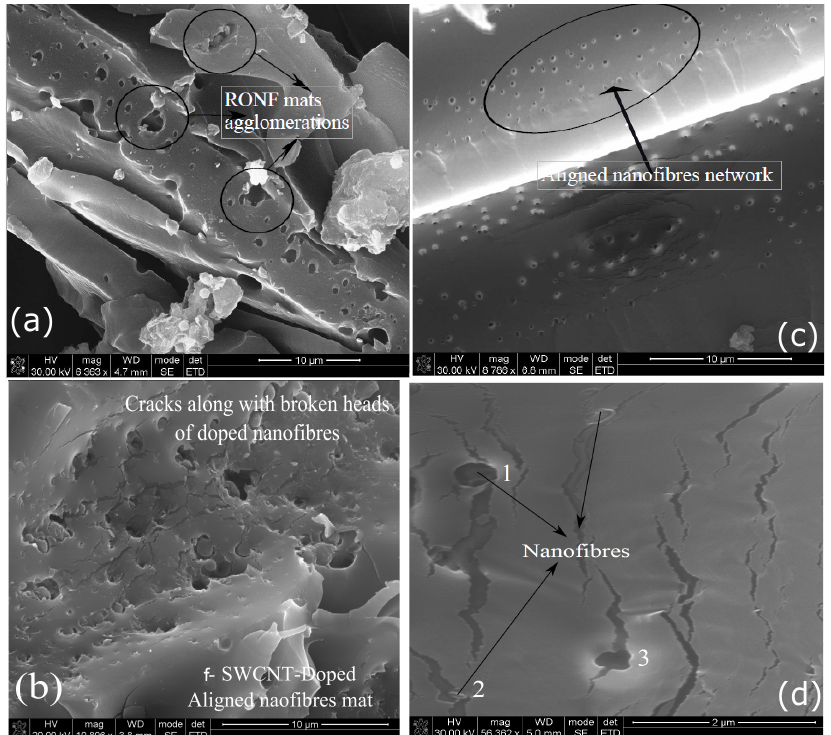
Figure 10. Fracture surfaces: ( a ) Agglomeration of RONFs mats strengthened hybrid composite tensile test specimen. ( b ) Tensile test specimen fracture surface of f-SWCNTs doped CANFs mats strengthened hybrid composite. ( c ) Fracture surface of the interlaminar regions with aligned nanomats networks of flexural test specimen. ( d ) Branched cracks within the interlaminar region due to nanofibers